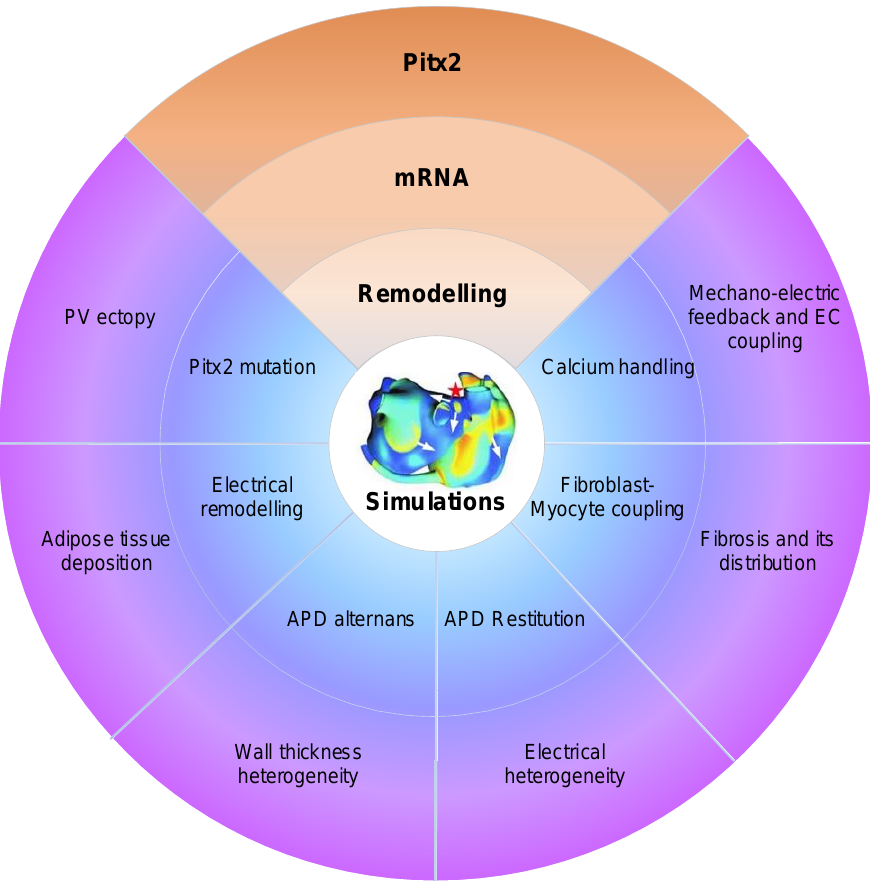
Figure 10. Mechanistic insights from multi-scale AF modeling of remodelling arising from impaired Pitx2. Pitx2 modulates microRNAs and thereby regulates distinct ion channels, cell-cell coupling and beta-adrenergic stimulation, resulting electrical remodelling, structural remodelling and calcium abnormalities. Pitx2-induced remodelling can be incorporated into the 3D human atria and simulations increase the AF mechanisms due to impaired Pitx2. Pitx2 mutation, electrical remodelling, calcium handling, gap junctional uncoupling, development of repolarization alternans, atrial stretch with mechano-electrical feedback, the fibrotic atrial substrate, tissue restitution properties, atrial wall thickness heterogeneity, electrical heterogeneity, adipose tissue deposition and pulmonary vein ectopy.